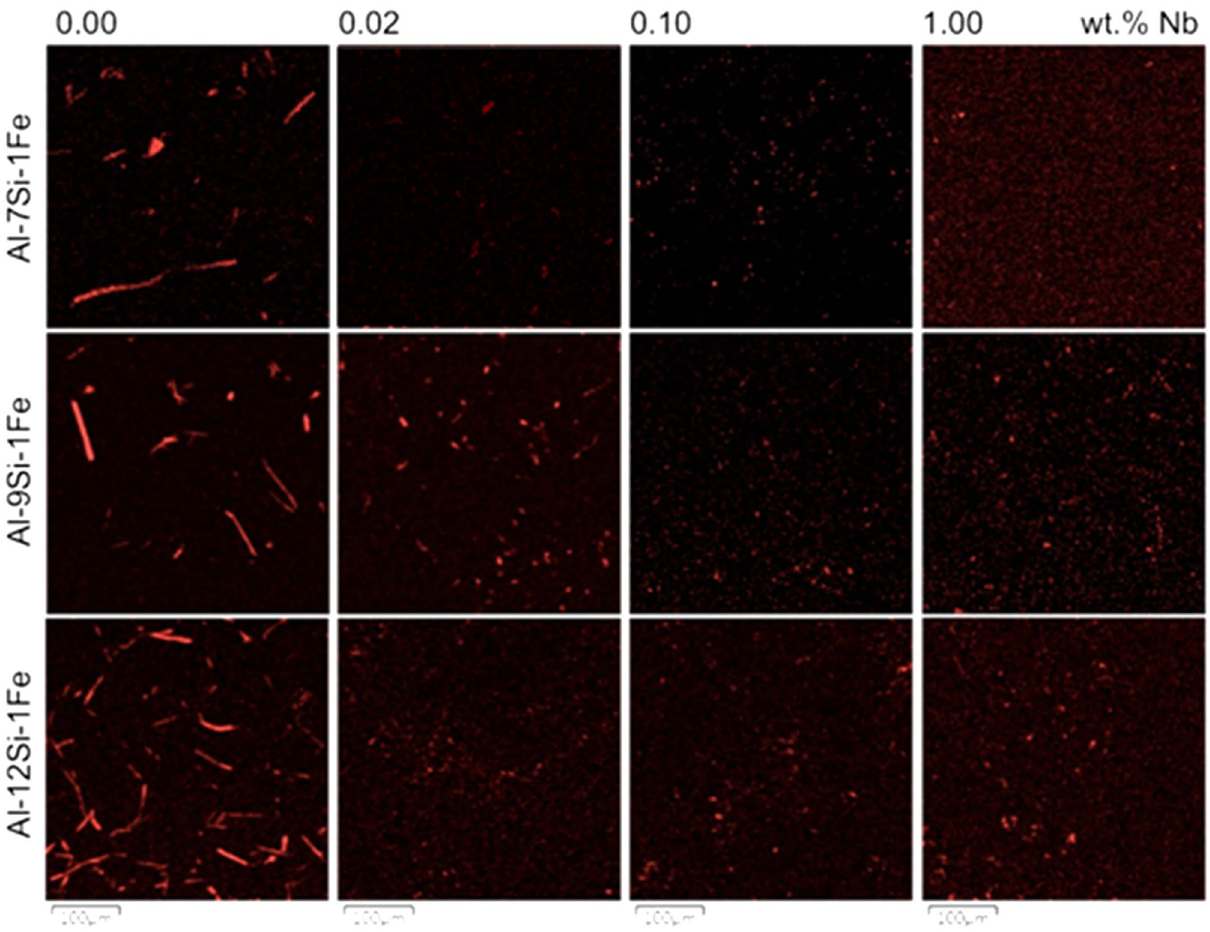
Figure 9. Fe-rich spectrum of the SEM–EDS images for the alloys containing 7, 9 and 12 wt% Si and 1 wt% Fe, without Nb addition (left) and with 0.02–1.00 wt% Nb and B as per stoichiometric calculation.